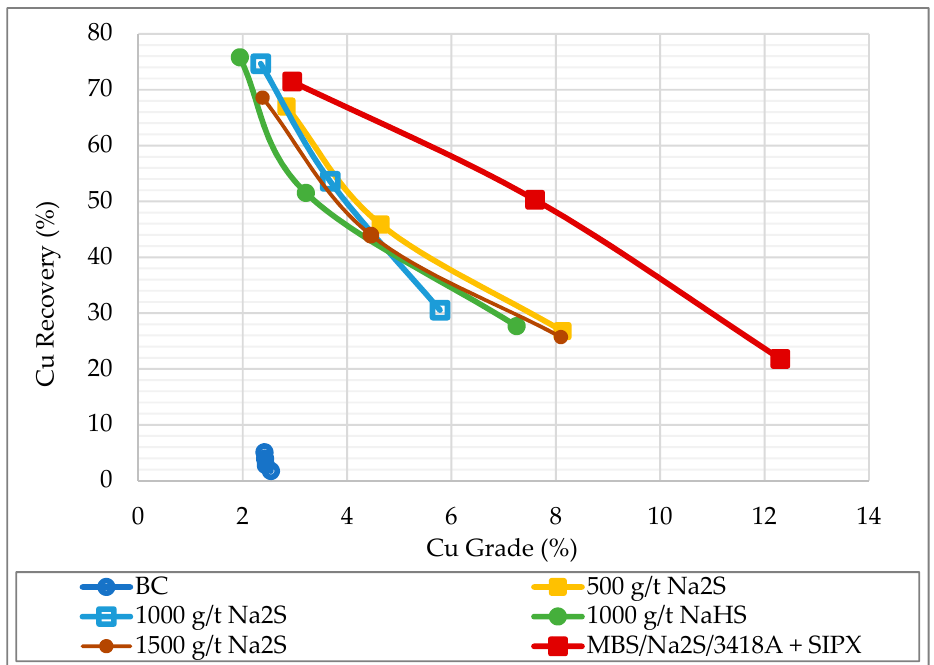
Figure 6. Effect of sulphidization and MBS addition on Cu recovery-grade of Ore B.